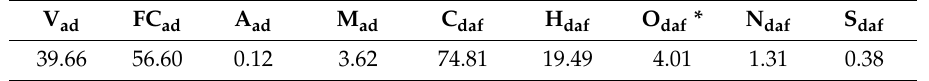
Table 1. Proximate and ultimate analyses of JX